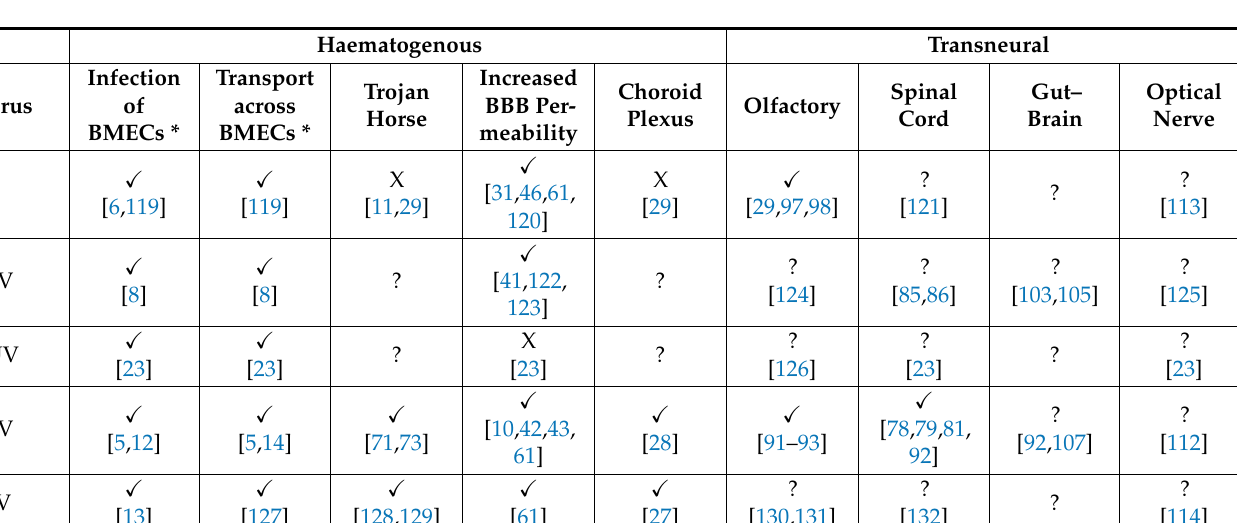
Table 3. Summary table of the potential modes of CNS invasion used by the neurotropic flaviviruses discussed in this review. (cid:88) = supported by experimental data. X = not supported by experimental data. ? = suggested or yet to be demonstrated. * = also includes differentiated iPSC and CD34+ cord blood-derived BMEC-like in vitro cell models.